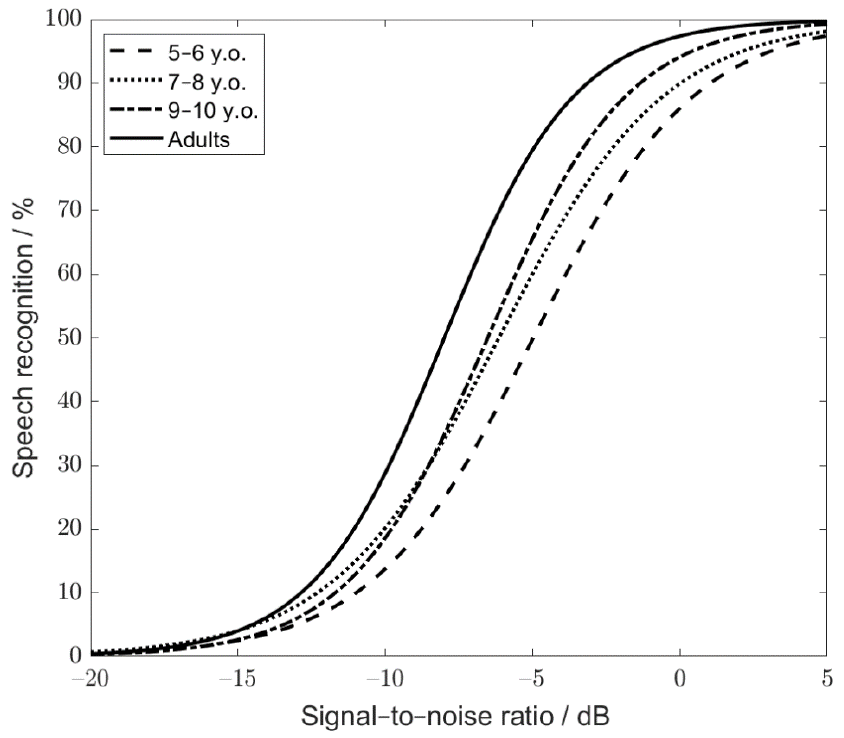
Figure 5. Test-specific function for 5–6 y.o. children (dashed line), 7–8 y.o. children (dash-dotted line) and 9–10 y.o. children (dotted line). The solid black line depicts the test-specific function for adults.